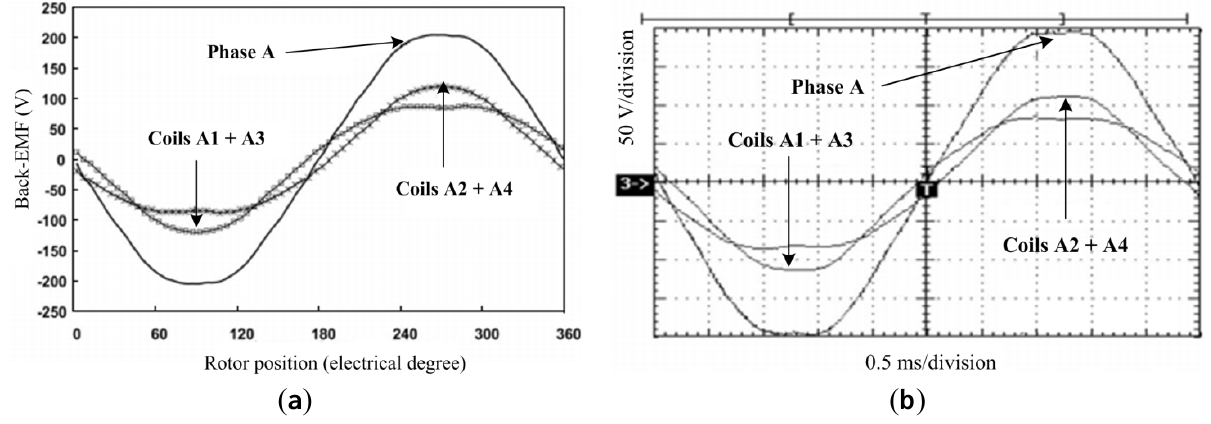
Figure 5. Coils and phase EMF waveforms of a 12/10-pole FSPM machine: ( a ) Predicted; ( b )